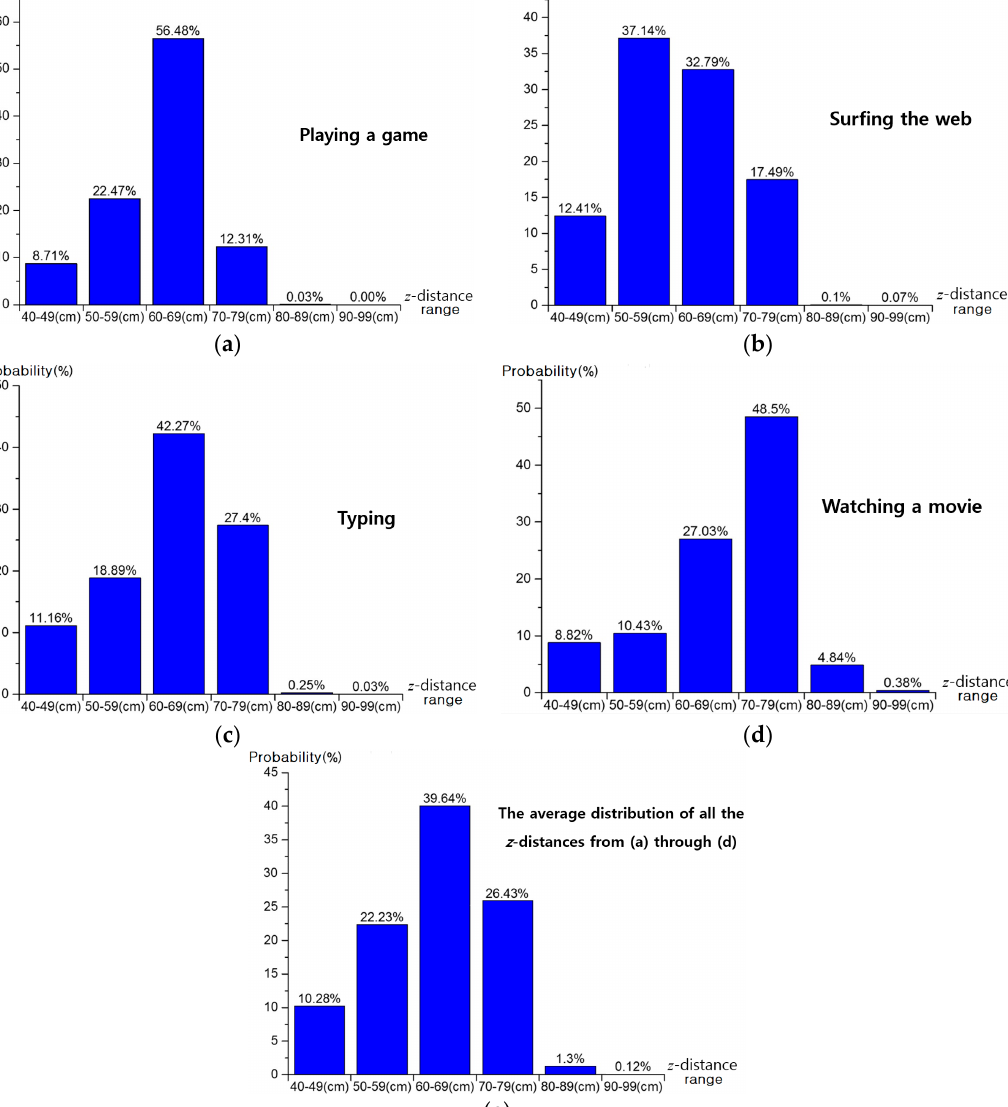
Figure 7. z -distance distributions of subjects measured by ultrasonic sensor when subjects were: ( a ) playing a game; ( b ) surfing the web; ( c ) typing; and ( d ) watching a movie. ( e ) The average distribution of all the z -distances from ( a ) to ( d ).